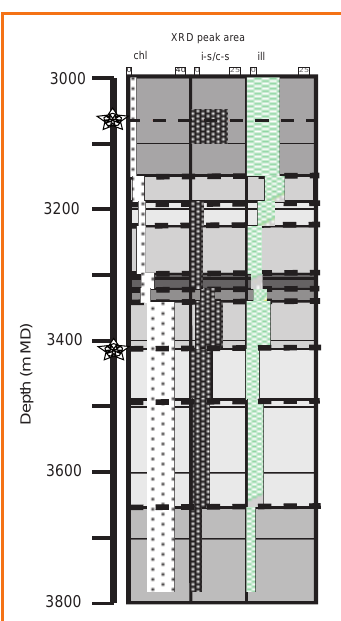
Figure 1. Mineralogic characteristics of the SAFOD main hole obtained from XRD powder patterns. Main minerals are chlorite (chl), illite (ill), mixed-layer illite-smectite and chlorite-smectite (i-s/c-s). Major boundaries are shown by dashed lines and bands correspond to lithologic units (Solum et al.,